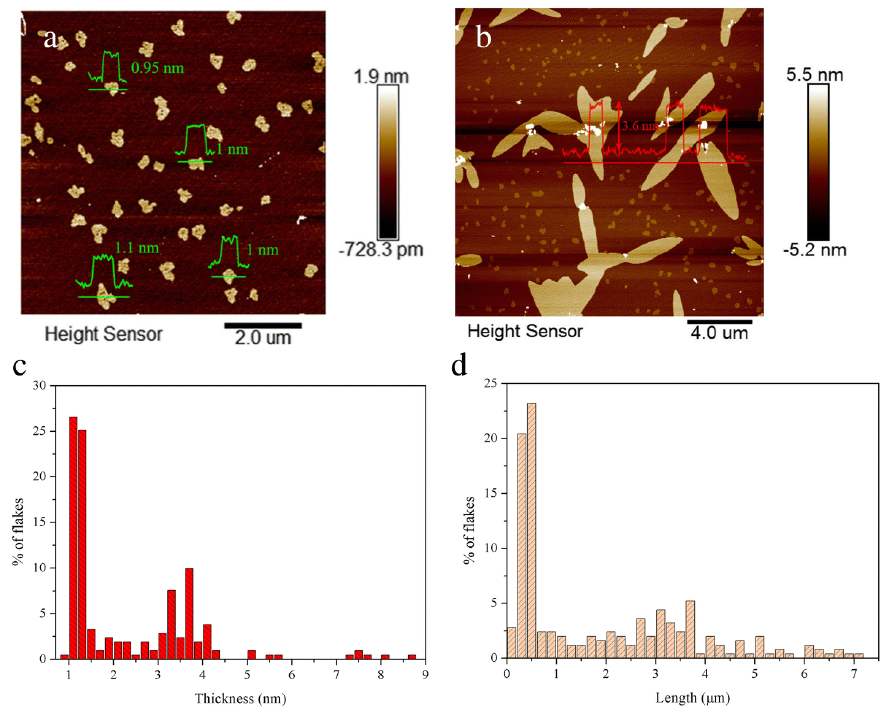
Figure 5. ( a ) AFM images of monolayer graphene flakes with adjacent height profiles; ( b ) different types of few-layer graphene flakes with adjacent height profiles; ( c ) the adjacent thickness of the flakes; ( d ) the length distribution of different flakes analyzed through AFM microscopy. Reproduced from [67]. [CC-BY].